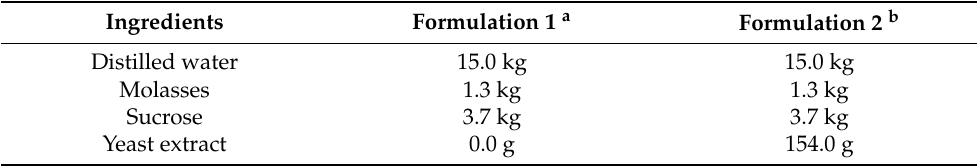
Table 1. Media composition used in all fermentation